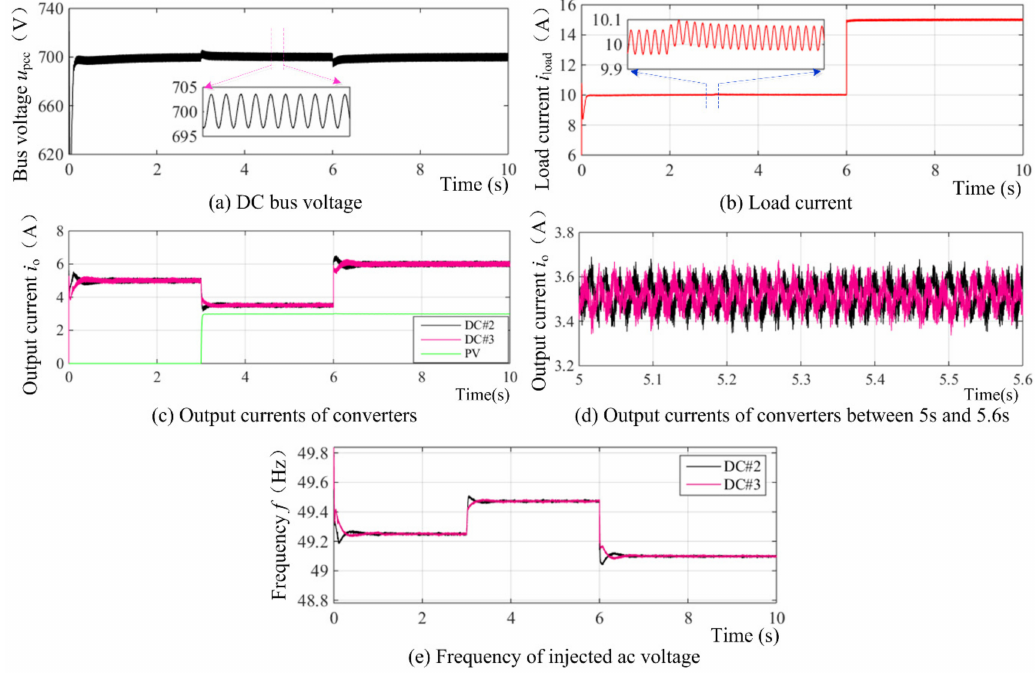
Figure 9. Simulation results of two equal converters considering the access of the PV converter.